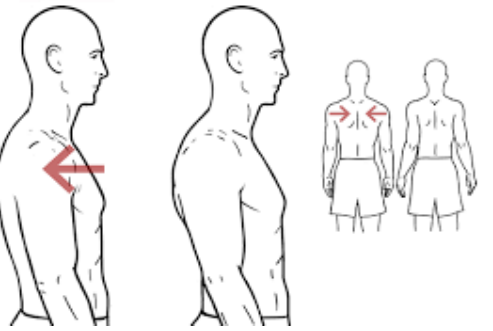
Figure 9. Scapular retraction (https://workoutsprograms.com/ejercicios/retraccion-escapular).